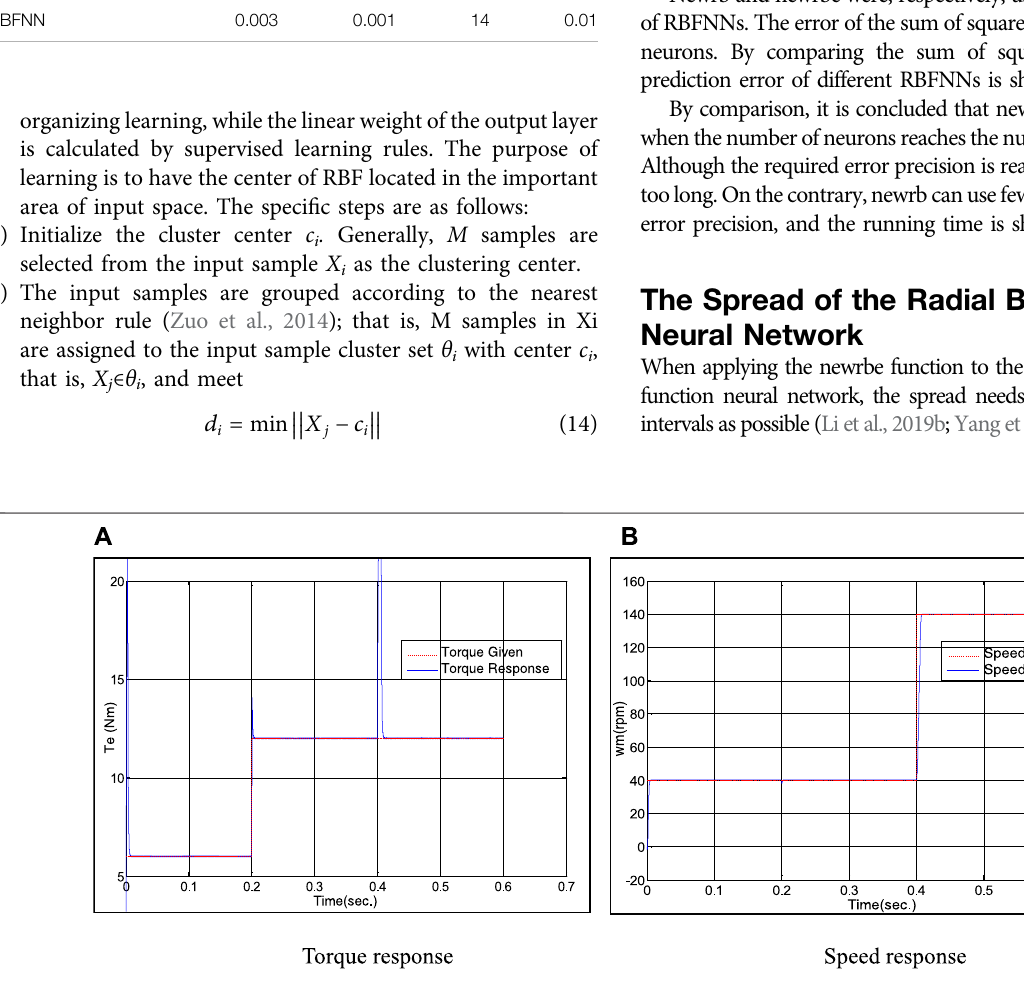
FIGURE 10 | Response curve of RBFNN inverse system decoupling